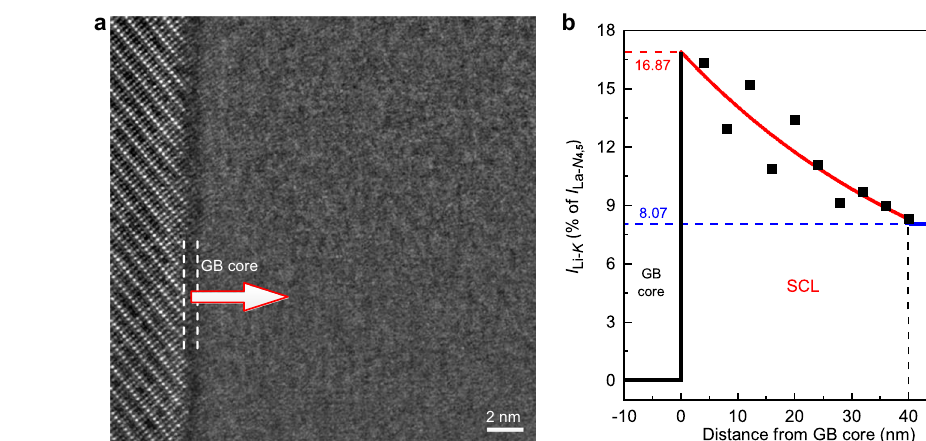
arethenormalizedLi- K intensityacquiredfromtheEELSline-scanexperiment.The black line is the normalized Li- K intensity within the GB core. The red curve is the exponential fi t conducted to the points between 0 and 40nm. The blue line denotes the normalized Li- K intensity in bulk, i.e.,